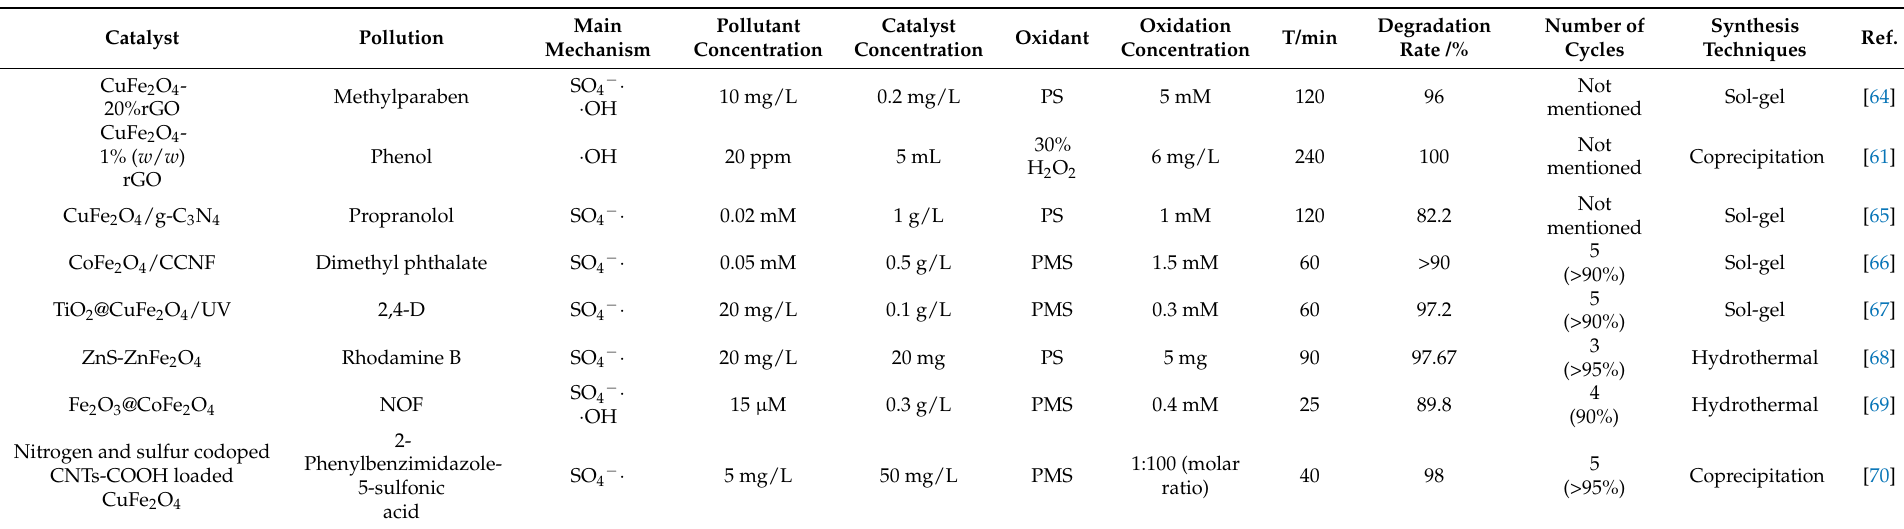
Table 2. Effects of partial MeFe 2 O 4 and carrier composite materials on degradation of different kinds of wastewater